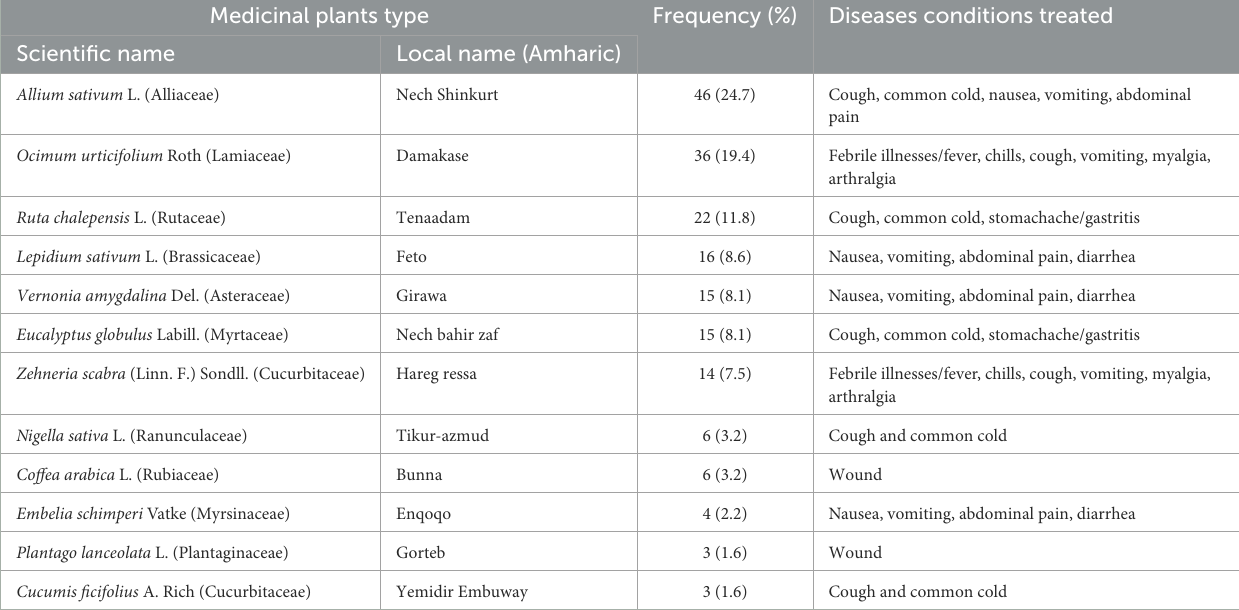
Medicinal plants